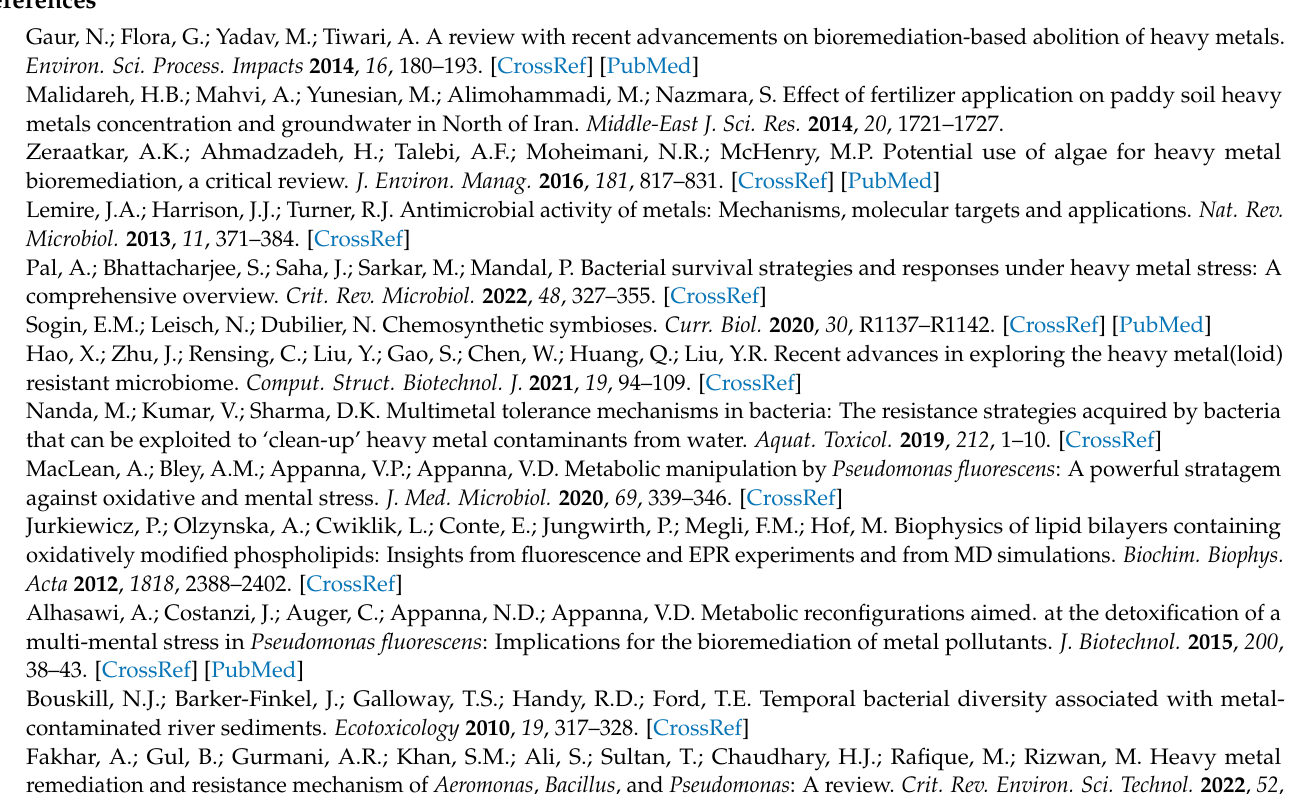
Table S3: The P-value and impact factor of significant pathways in the logarithmic phase; Table S4: The P-value and impact factor of significant pathways in the stable phase; Figure S1: Permutation test chart of copper exposed group and untreated group in the stable phase; Figure S2: Permutation test chart of copper exposed group and untreated group in the logarithmic